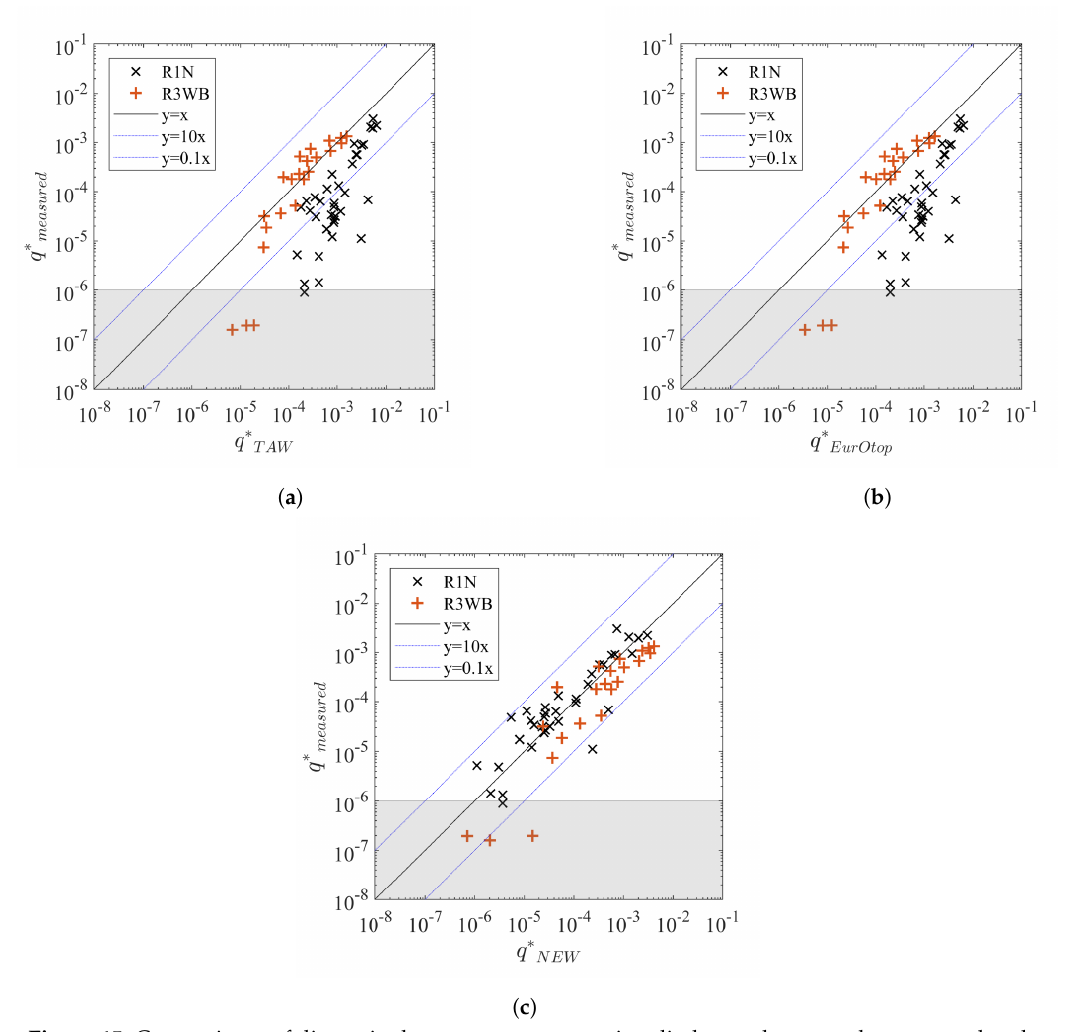
Figure 15. Comparisons of dimensionless average overtopping discharges between the measured and the predicted values for the Datasets R1N and R3WB using ( a ) the TAW equations given by [6], ( b ) the EurOtop equations given by [10] and ( c ) the new